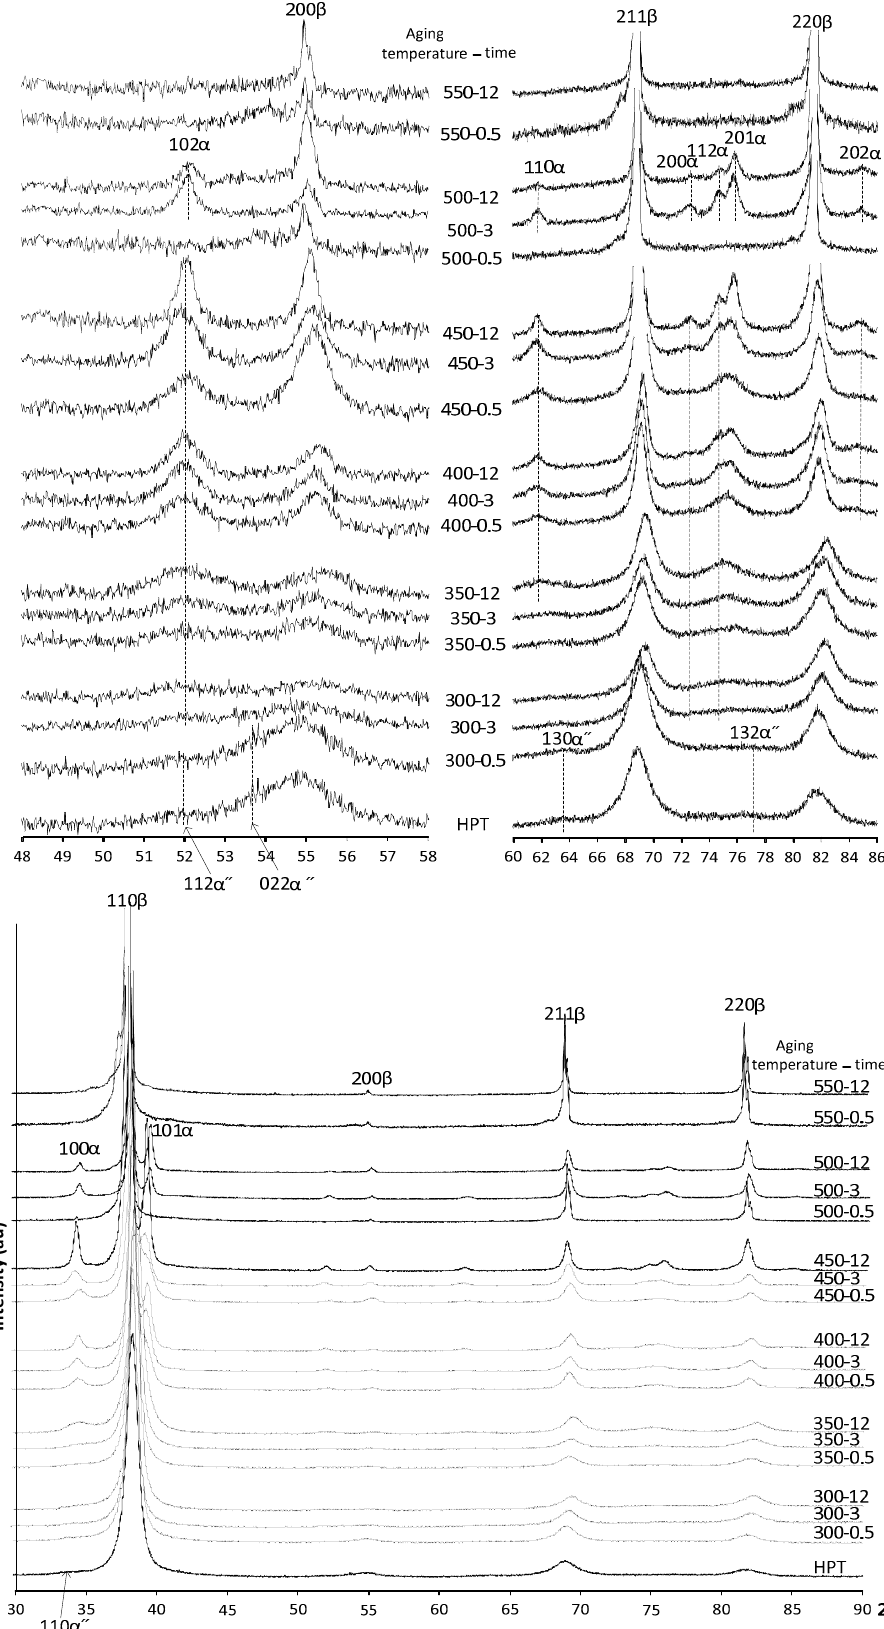
Figure 2. X-ray diffractograms of Ti-18Zr-15Nb alloy after HPT and aging.